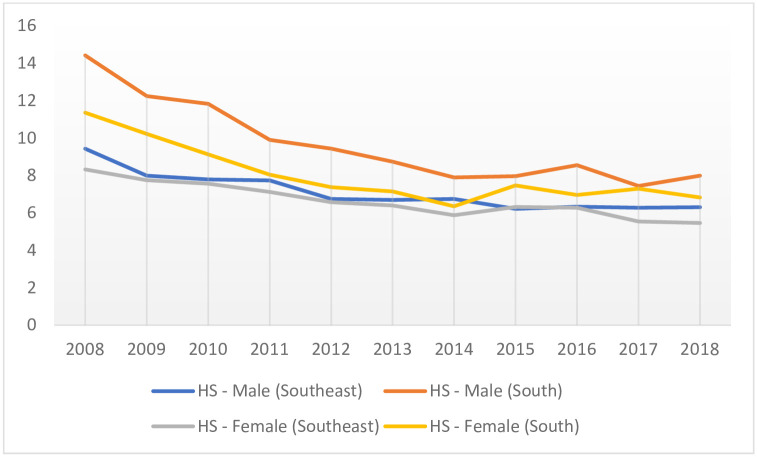
Temporal trend of the incidence of hospitalizations (x100,000 inhabitants) due to haemorragic stroke, stratified by gender in developed regions of Brazil, 2008–2018.HS—Hemorrhagic Stroke; x-axis: years; y-axis: incidence of hospitalization rates.